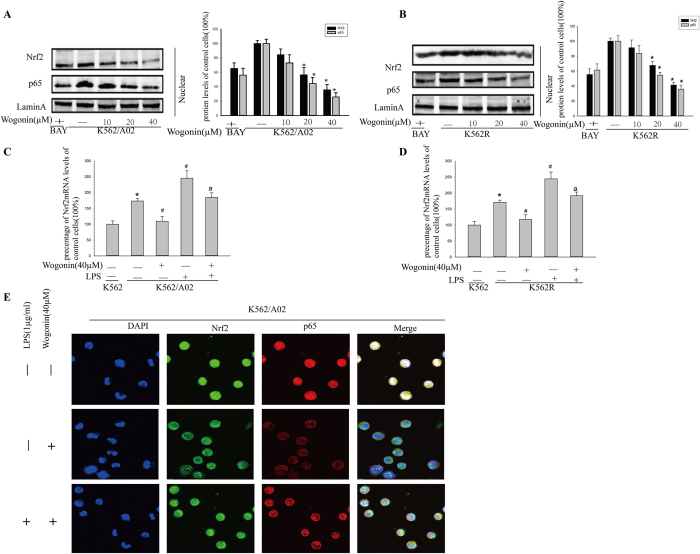
Wogonin inhibited Nrf2 transcription via NF-κB pathway.(A,B) The expression of nuclear protein p65 and Nrf2 was assessed by Western blot analysis in treatment with 5 μM BAY11-7082 for 6 h or various concentrations of Wogonin for 24 h in K562/A02 and K562R cells, respectively. Nuclear protein expression was normalized to lamin A levels. *p < 0.05 versus untreated cells. (C,D) K562/A02 and K562R cells were pretreated with 1 μg/ml LPS for 4 h and then treated with or without 40 μM Wogonin for 24 h. Levels of Nrf2 mRNA in treated K562, K562/A02 and K562R cells were determined by RT-PCR. *p < 0.05 versus untreated K562 cells. #p < 0.05 versus untreated K562/A02 or K562R cells. ap < 0.05 versus 40 μM Wogonin. (E) K562/A02 cells were pretreated with 1 μg/ml LPS for 4 h and then treated with or without 40 μM Wogonin for 24 h, respectively. Nuclear translocalization of p65 and Nrf2 was assessed by IF using a confocal laser microscope, Nrf2 (green), p65 (red), DAPI (blue). All results were represented as the mean ± SD of three independent experiments.